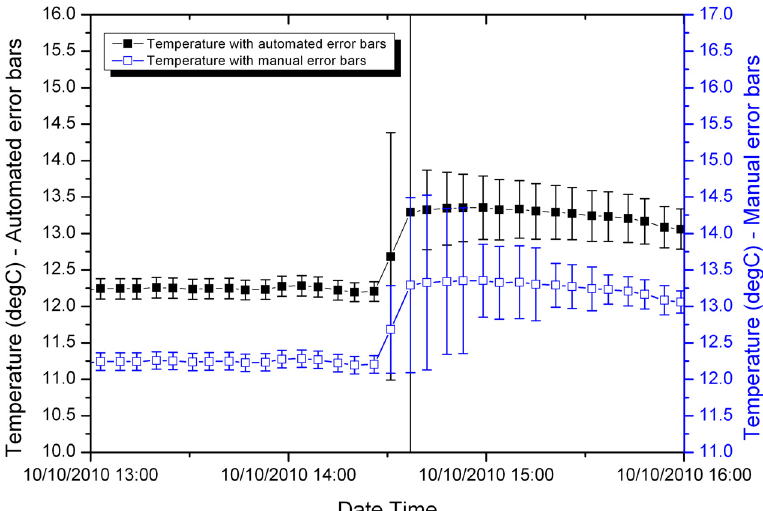
Figure 5. Shallow water temperature with manually calculated and automatically generated error bars for a period late in the sensor deployment.